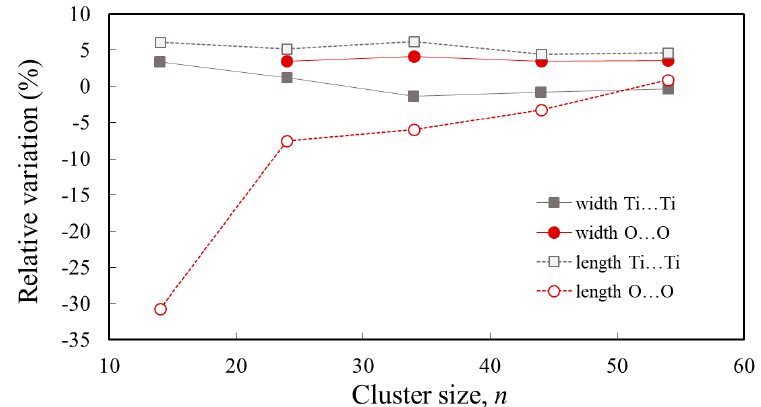
Figure 2. The relative cluster width, ( w n − w bulk ) / w bulk , and length, ( l n − l bulk ) / l bulk , of Ti n O 2 n +2 H 4 , nanoclusters (where n = 14, 24, 34, 44, 54) with respect to the corresponding value for the bulk anatase TiO 2 [72]. The distances are measured between peripheral Ti (grey) or O (red) atoms. Table 2. The number of Ti or O atoms m -fold coordinated ( m x) to O or Ti atoms, respectively, and the surface-to-bulk ratio (s/b, determined as the fraction of under-coordinated atoms [36]). Parameter